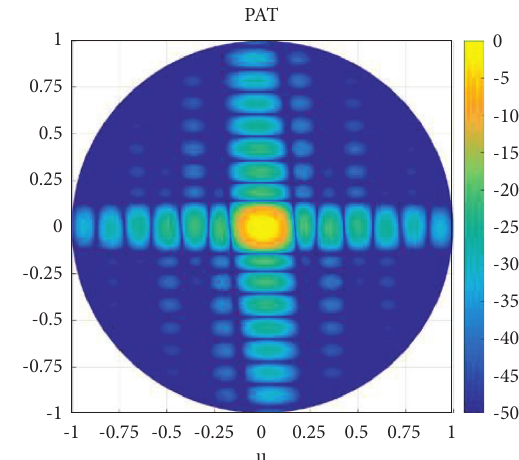
Figure 12: Change of the position error pattern of the left and right half arrays in the Y -direction ( 0 . 2 λ ) .